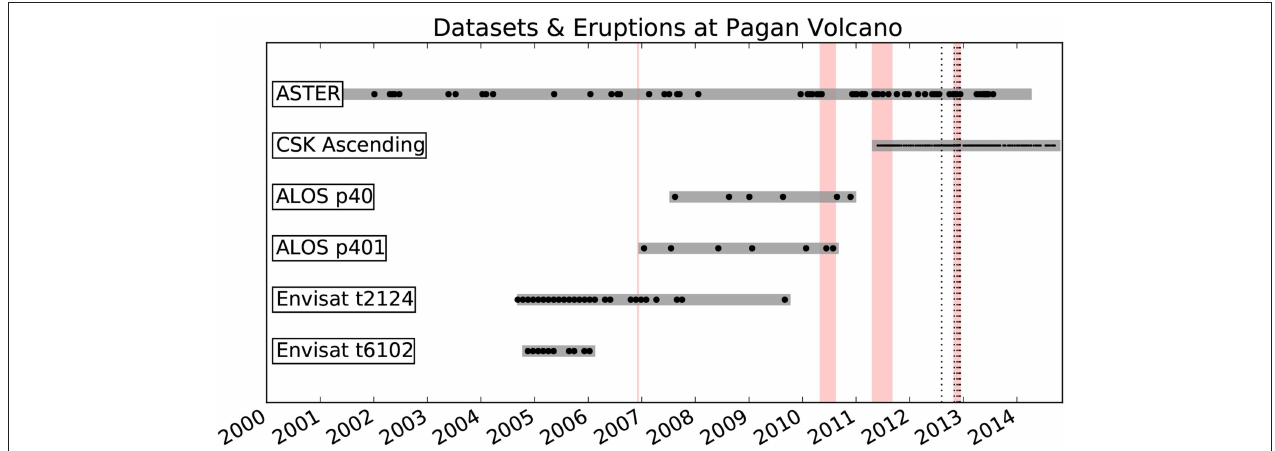
FIGURE 2 | Timeline of remote sensing data with respect to recorded eruptive activity. Gray horizontal lines indicate available data in archives. Black dots indicate dates of acquisitions used in this study: For ASTER, these represent usable cloud-free night-time scenes; for ALOS, these were the only dates available to us; for Envisat, these are all archived dates. Red vertical bars are confirmed eruptive activity (VEI 1-2) ( Global Volcanism Program, 2013). MODIS observations are nearly daily since 2000 (not shown), with occurrence of MODVOLC thermal anomaly warnings indicated with vertical dotted